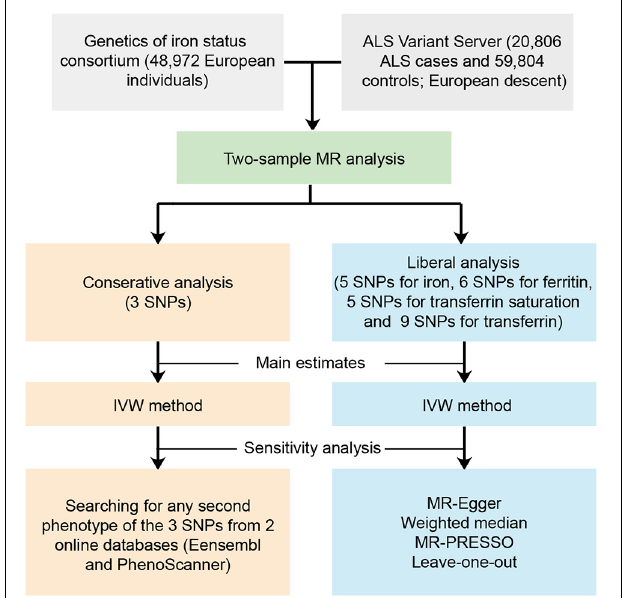
FIGURE 1 | Workflow of the Mendelian randomization study investigating the causal effect of iron status on risk of amyotrophic lateral sclerosis. ALS, amyotrophic lateral sclerosis; SNP, single nucleotide polymorphisms; MR, Mendelian randomization; IVW, inverse variance weighted; MR-PRESSO, Mendelian randomization pleiotropy residual sum and